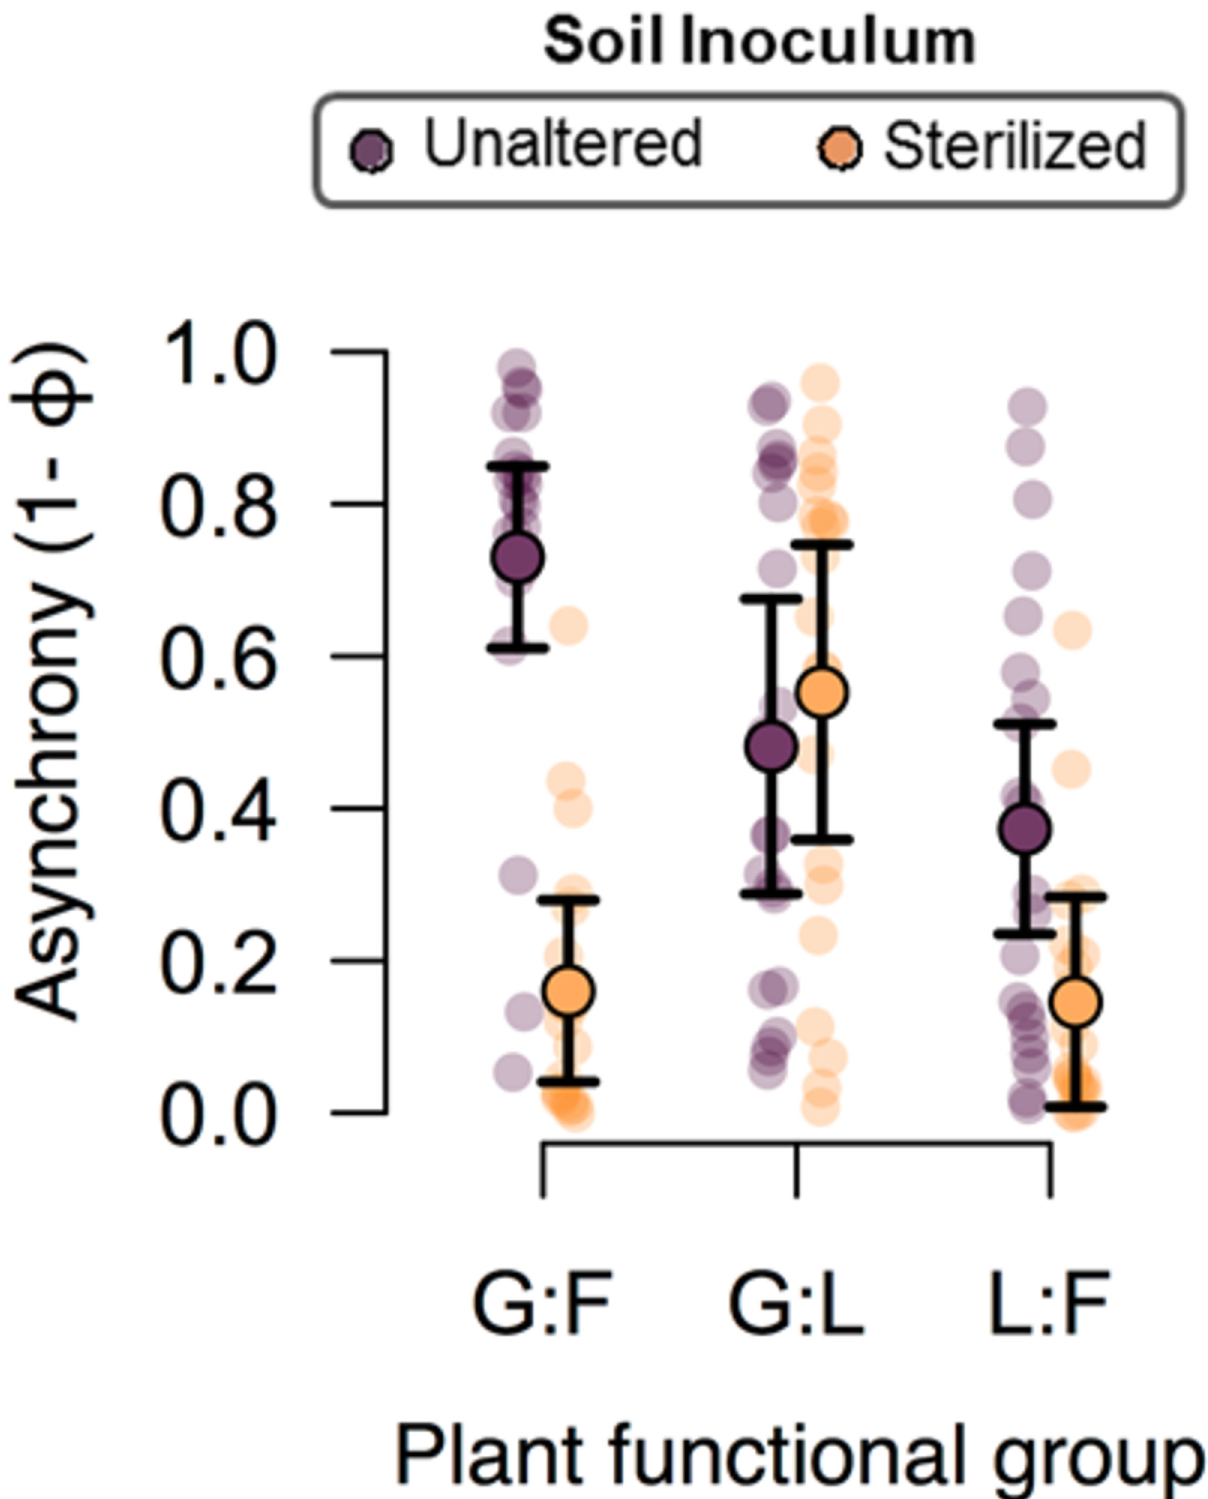
Fig 5. Mean asynchrony between pairs of plant functional groups in the two inoculum treatments. The unaltered soil inoculum is shown in darkly colored points and the sterilized inoculum treatment in light colored points. Bars represent 95% confidence intervals. G = grasses, F = forbs, L = legumes. Lightly shaded individual points are values for individual